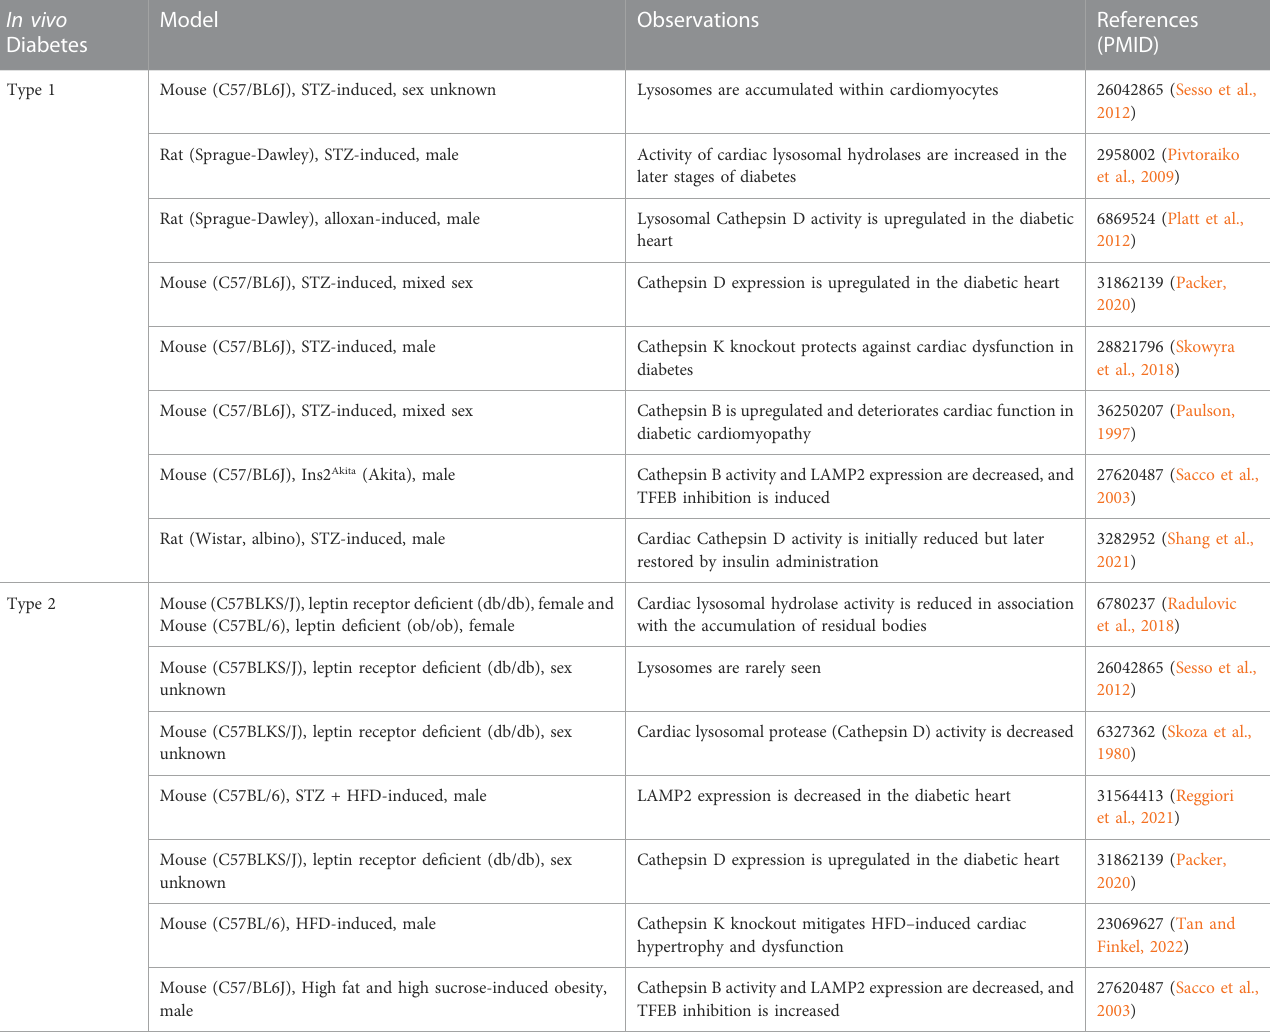
TABLE 1 Studies demonstrating lysosomal dysfunction and/or LMP in the diabetic heart. In vivo